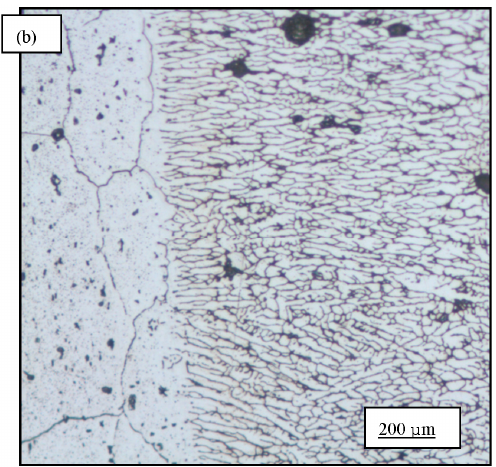
Figure 5. Optical micrographs showing the following: ( a ) Microstructure at the weld-base metal interface of the as-welded Aluminum alloy 6061-T4; ( b ) microstructure of the weld-base metal interface in the post weld heat treated aluminum alloy 6061.